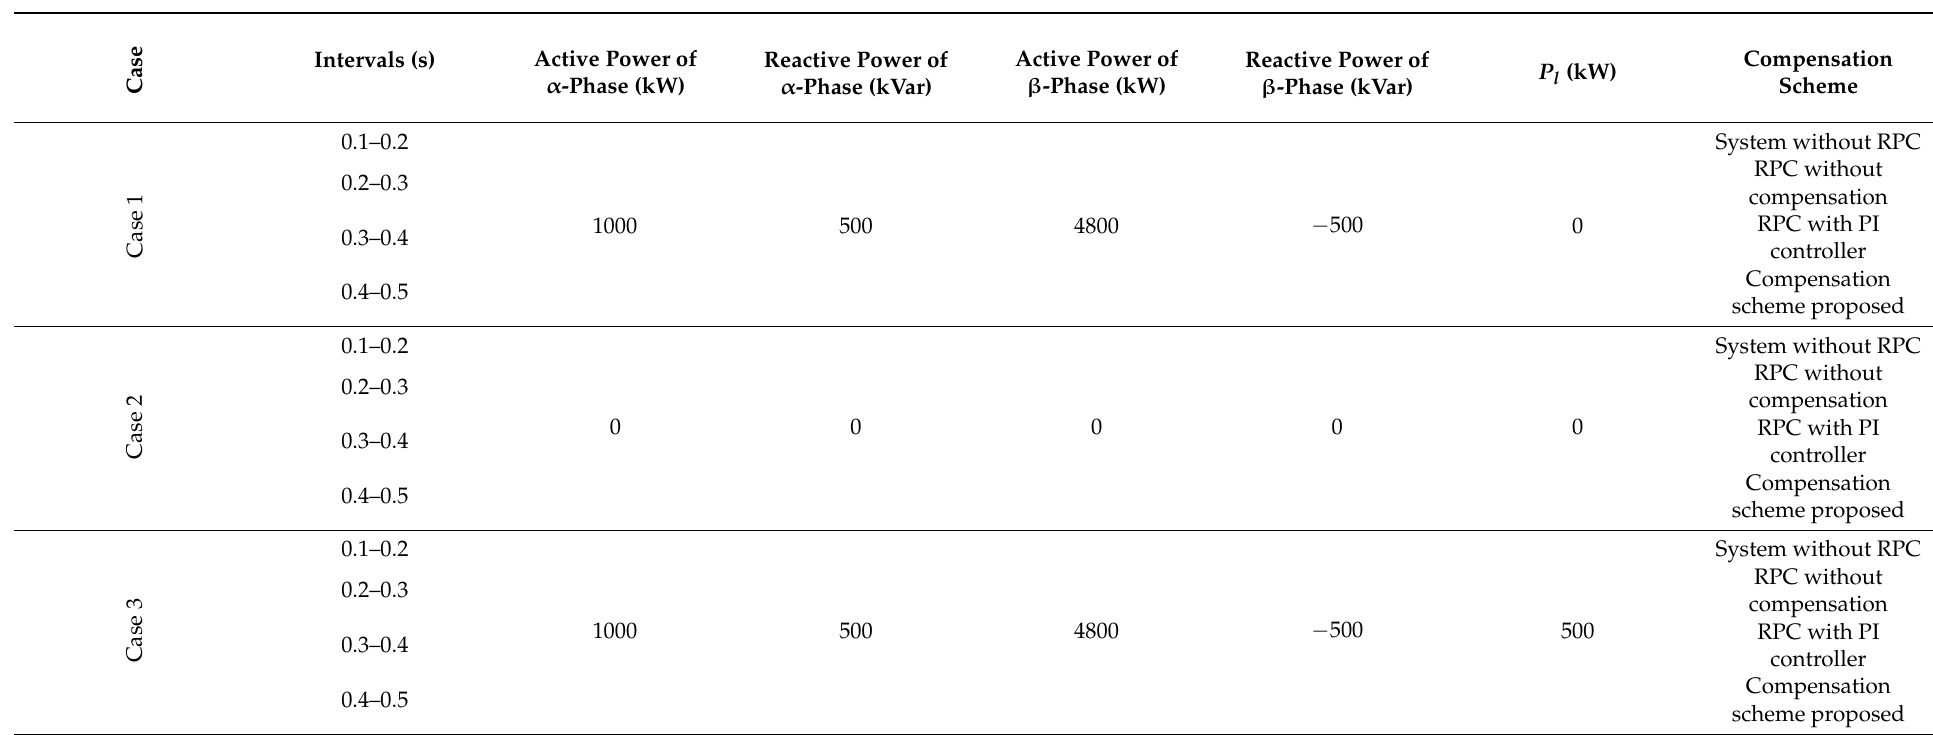
Table 5. Simulation parameters of